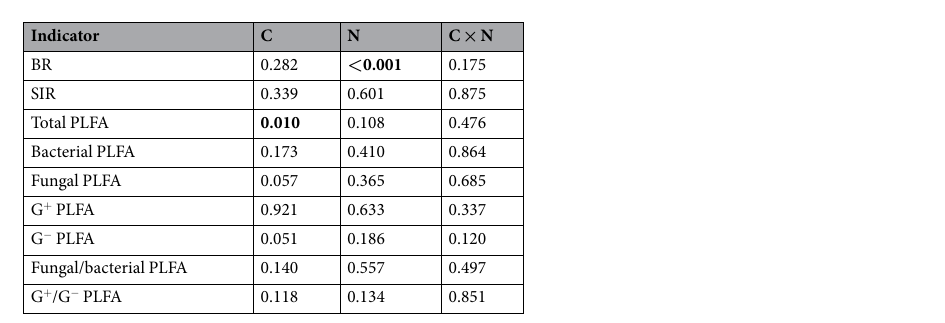
Table 3. P values for the effects of elevated CO 2 (C), N addition (N), and their interaction on rhizospheric effects. Significant P values are highlighted in